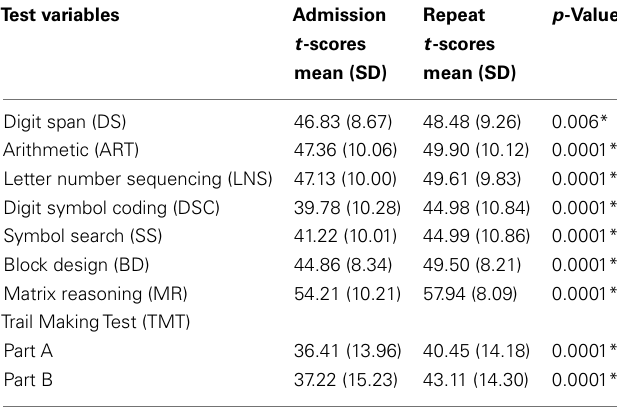
neuropsychological test